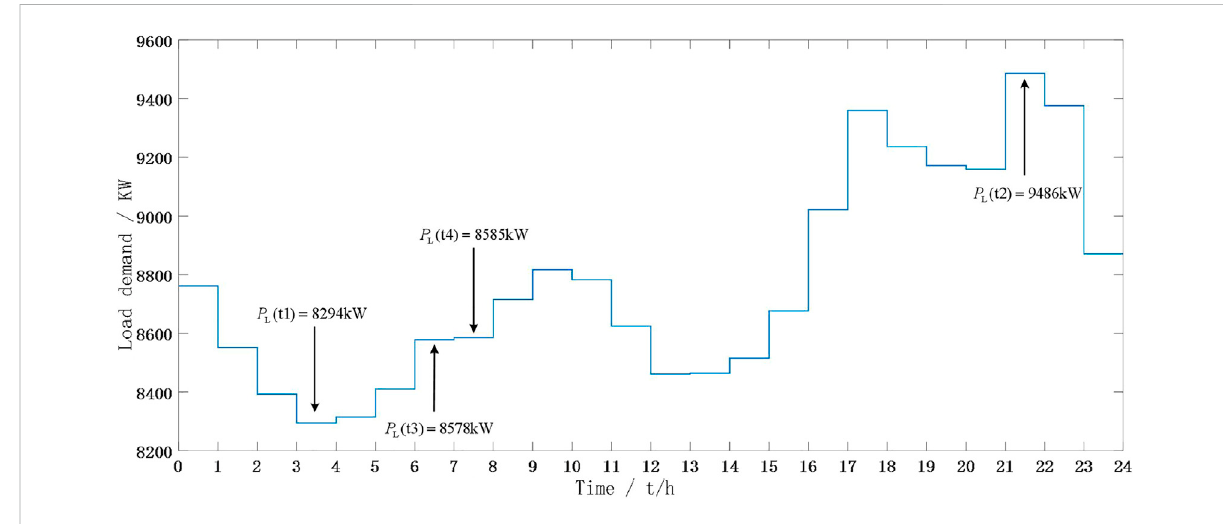
FIGURE 4 Regional daily load curve.